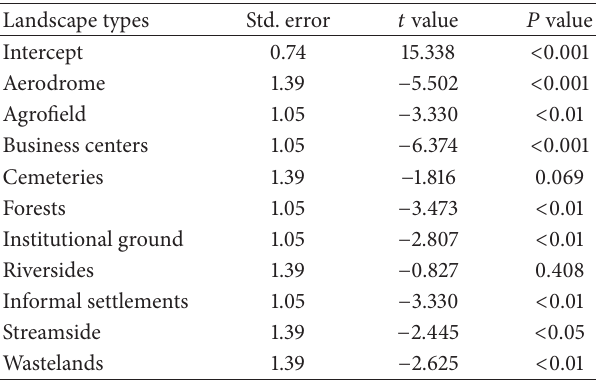
Figure 3: Total bird species in microlandscape types (AM: aero- drome; AG: agrofields; BC: business centers; CM: cemeteries; FT: forests; IS: informal settlements; IG: institutional grounds; RN: residential neighborhoods; RS: riversides; SS: streamside; WL: wasteland). Table 2: LMM output showing parameter estimates of microland- scape types on the number of bird